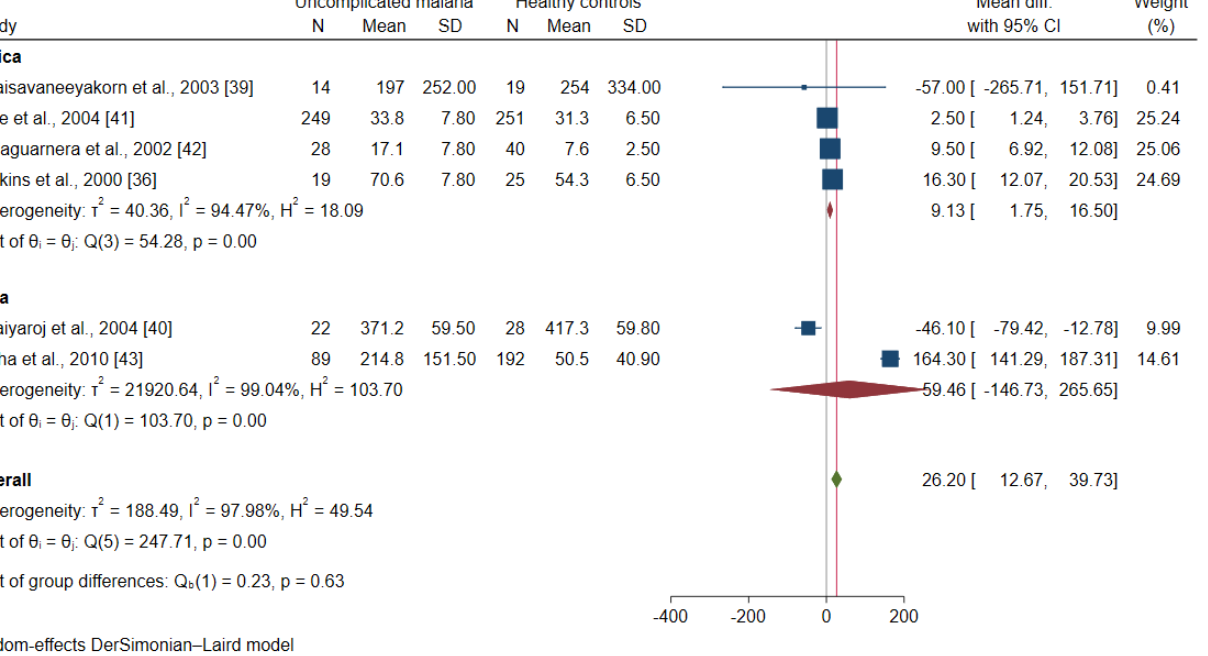
Figure 7. Forrest plot demonstrated the difference in the mean IL-12 levels (pg/mL) between patients with uncomplicated malaria and healthy controls by age groups [36,39–43]. Abbreviation: Mean Diff., mean difference; CI, confidence interval. Explanation of the forest plot: squared-box symbol, point estimate; green diamond and red line: pooled mean difference: red diamond: pooled mean